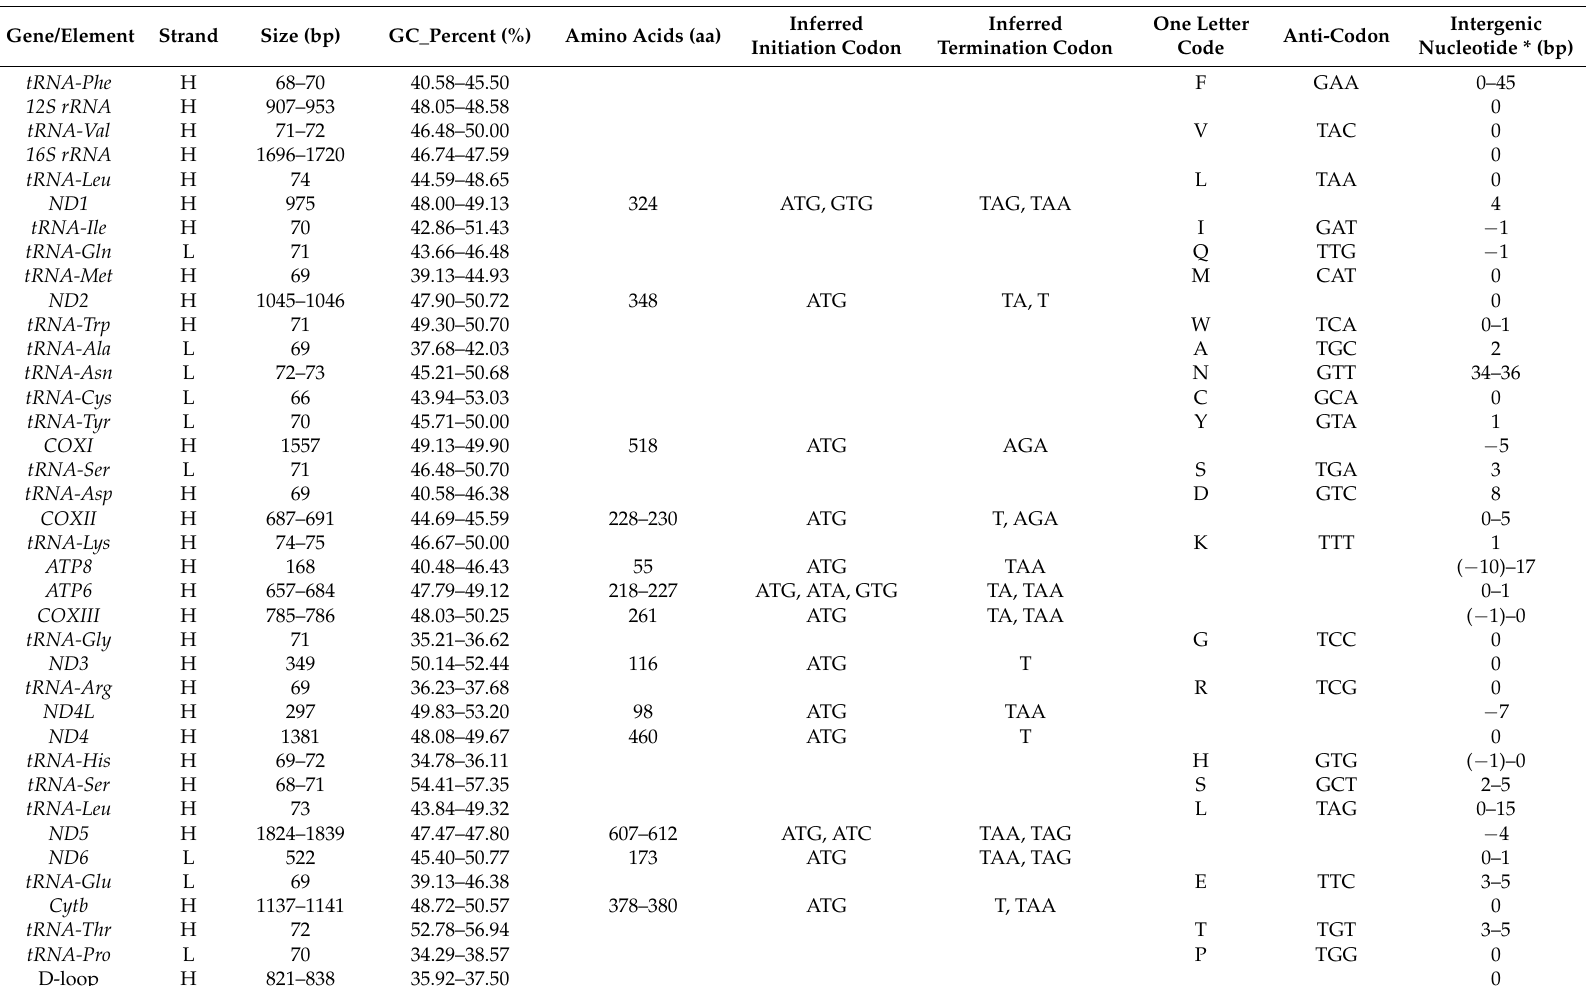
Table 2. Summary of gene/element feature of A. amoyensis , N. coibor , and P. diacanthus